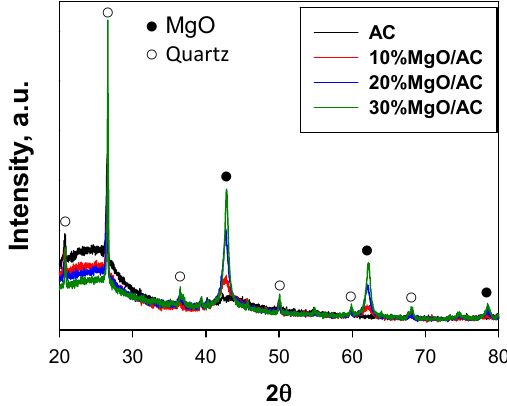
Figure 3. XRD patterns of raw AC and 10, 20, and 30 wt% MgO/AC.